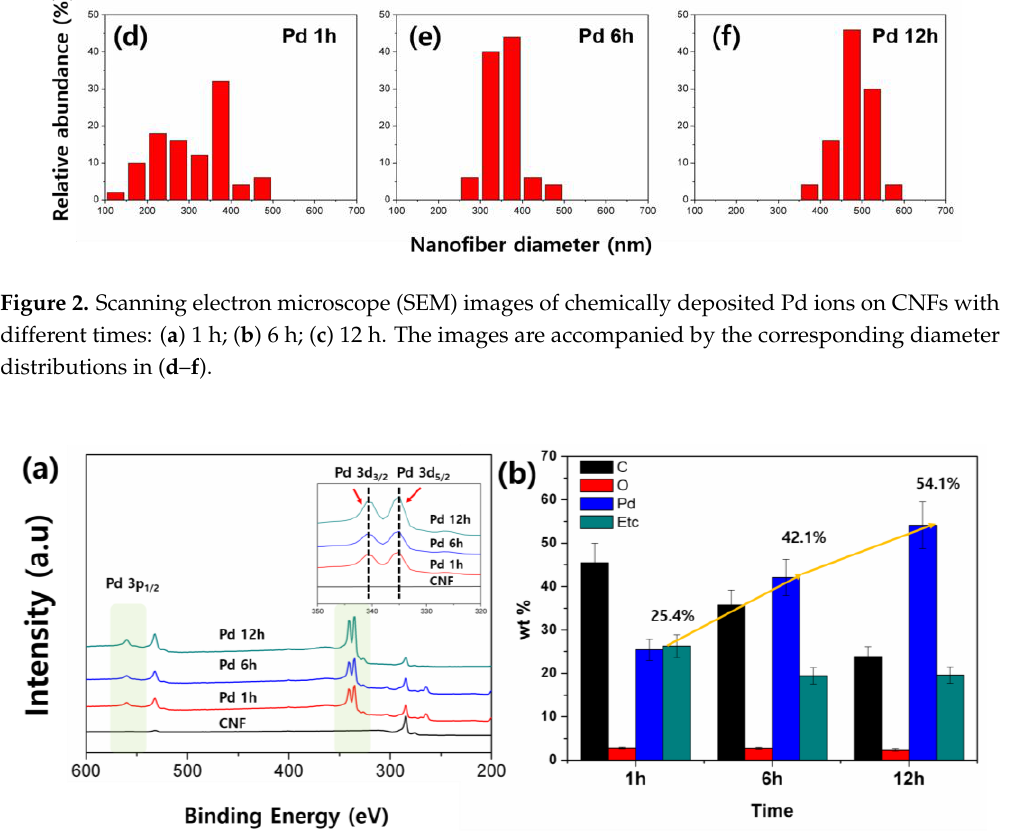
Figure 2. Scanning electron microscope (SEM) images of chemically deposited Pd ions on CNFs with different times: ( a ) 1 h; ( b ) 6 h; ( c ) 12 h. The images are accompanied by the corresponding diameter distributions in ( d – f ).